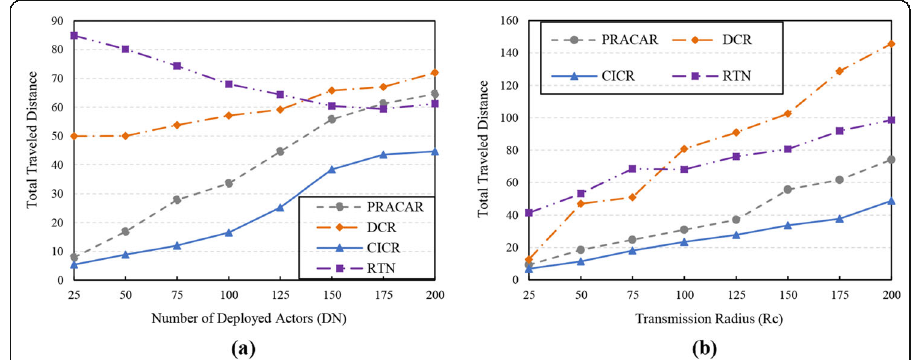
Fig. 9 The total traveled distance in the six partitions of network with varying ( a ) the number of actor s( R c = 100), ( b ) the transmission radius (DN =